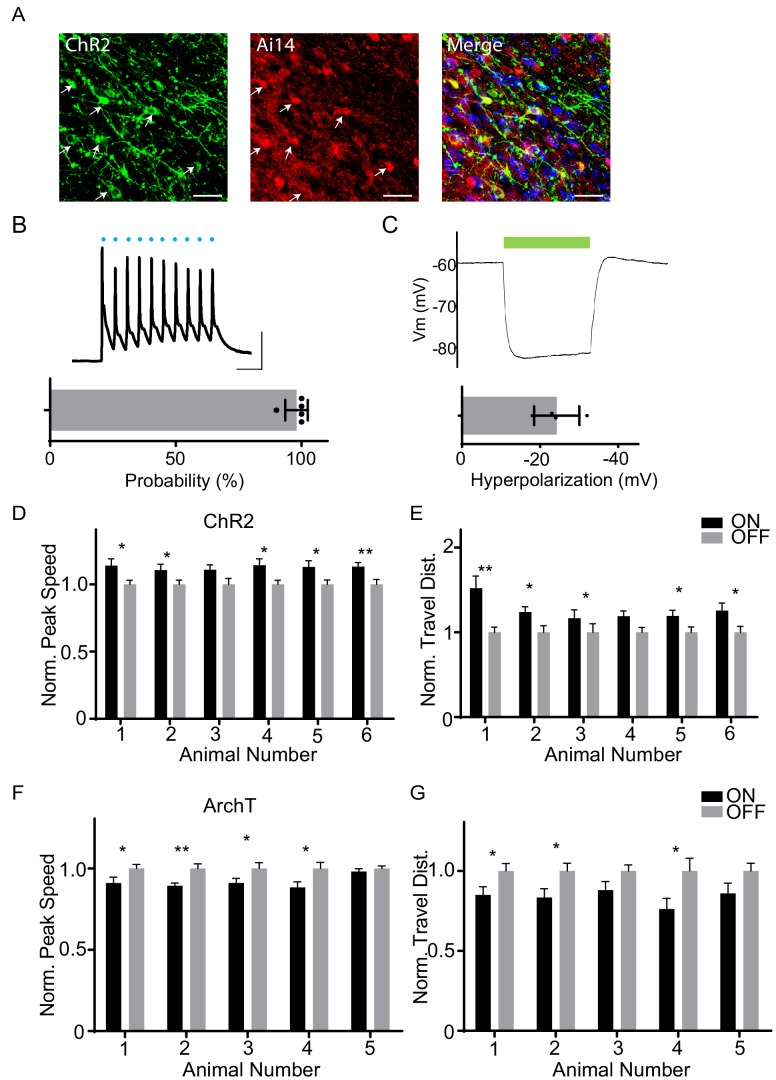
Tests of efficacies of ChR2 and ArchT stimulation and analysis of individual animals.(A) Confocal images showing the expression of ChR2 (green) and tdTomato (red) in ZIv in a PV-Cre::Ai14 animal. White arrows point to cells showing colocalization of ChR2 and tdTomato. Scale: 50 µm. (B) Upper, blue light induced spiking in an example ChR2-expressing neuron. Each blue dot represents a blue light pulse. Scale: 20 mV, 100 ms. Lower, summary of probability of spiking in response to 10 pulses (at 20 Hz) of blue light stimulation (n = 5 neurons). (C) Upper, green light (500 ms duration) induced hyperpolarization in an example ArchT-expressing neuron. Lower, summary of maximum level of hyperpolarization induced by light for 4 recorded neurons. (D) Normalized peak speed for each animal without (gray) and with (black) blue LED light stimulation for the ChR2 group. **p<0.01, *p<0.05, two-sided unpaired t-test. Error bars represent mean ± s.e.m. (E) Normalized total travel distance for each animal without (gray) and with (black) blue LED light stimulation for the ChR2 group. **p<0.01, *p<0.05, two-sided unpaired t-test. Error bars represent mean ± s.e.m. (F) Normalized peak speed for each animal without (gray) and with (black) green LED light stimulation for the ArchT group, **p<0.01, *p<0.05, two-sided unpaired t-test. Error bars represent mean ± s.e.m. (G) Normalized total travel distance for each animal without (gray) and with (black) green LED light stimulation for the ArchT group. *p<0.05, two-sided unpaired t-test. Error bars represent mean ± s.e.m.